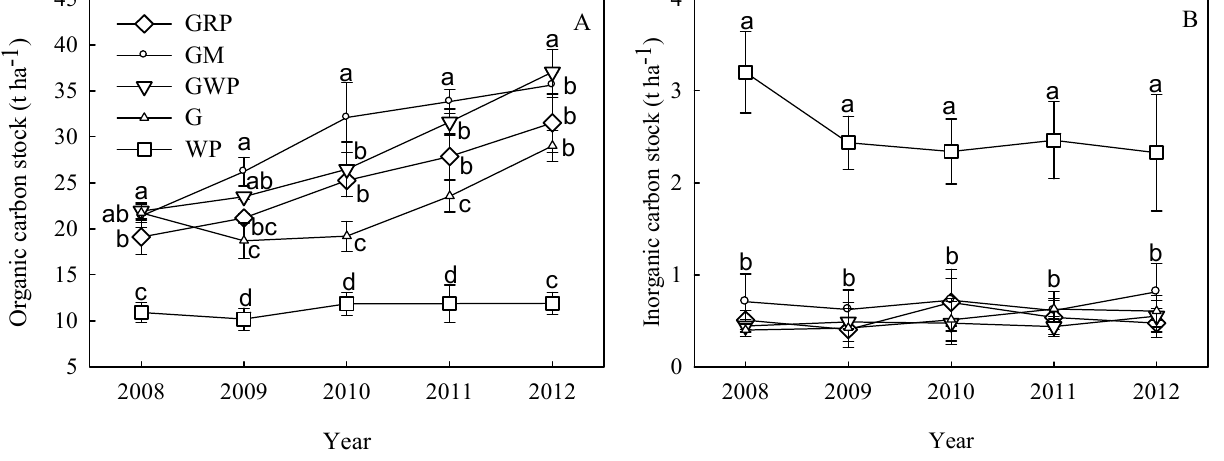
Figure 1. Soil organic carbon ( A ) and inorganic carbon ( B ) stocks in the 0–20 cm soil layer for five planting treatments, over the years 2008–2012. Vertical bars are the standard deviation ( n = 3). Letters denote significant differences among treatments within a given year ( p < 0.05). Abbreviations: GRP, Ginkgo + rapa + peanut; GM, Ginkgo + mulberry; GWP, Ginkgo + wheat + peanut; G, Ginkgo afforestation; and WP, wheat + peanut. Note differences between panels in the ordinate